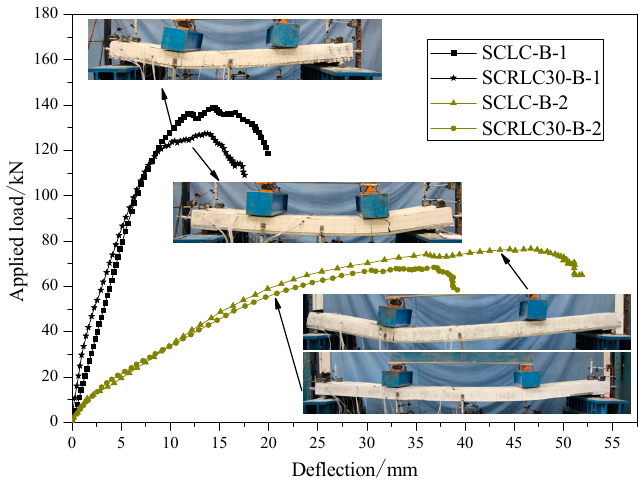
Figure 11. Load–deflection curves of different composite slabs at mid-span.